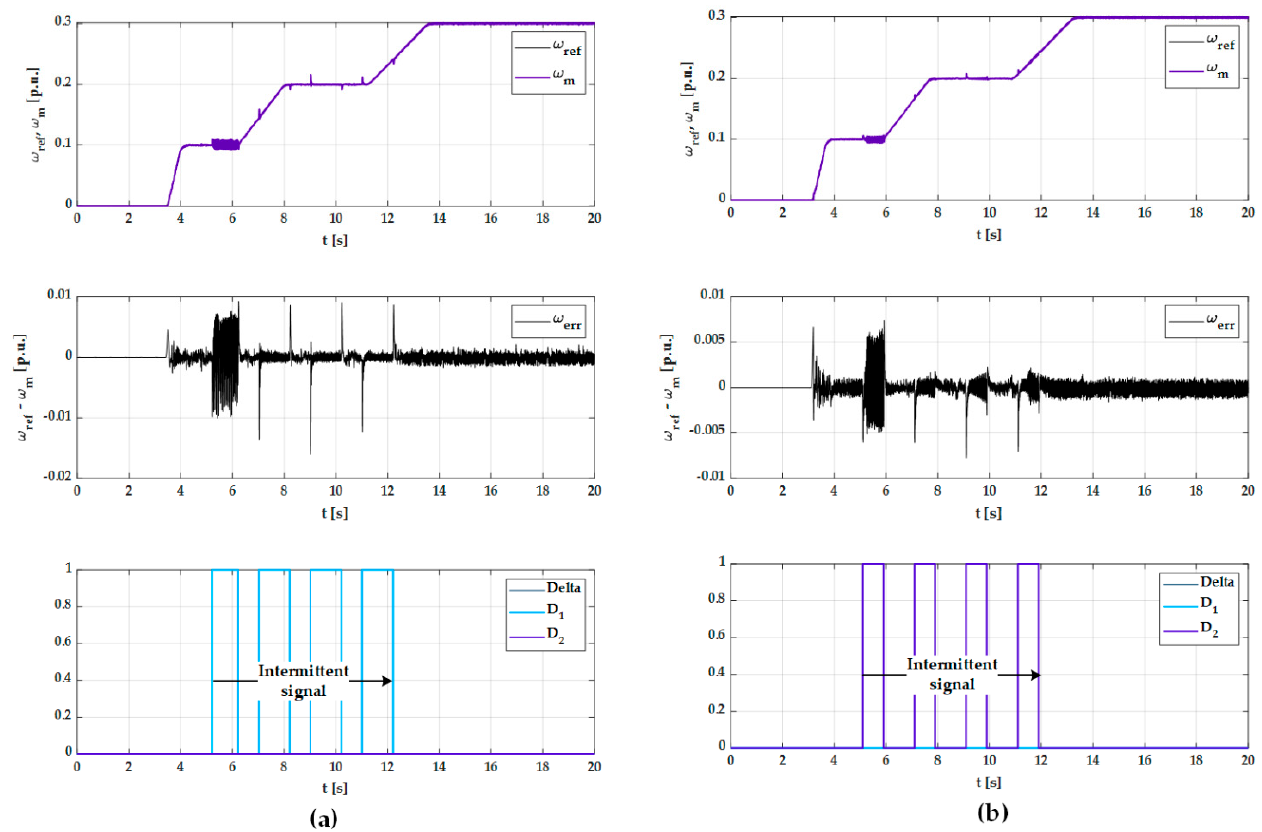
Figure 11. Transients of speed, speed error and detector response during signal interruptions in phase A with a motor load of 0.1 T N ( a ) and phase B with a load of 0.2 T N ( b ).